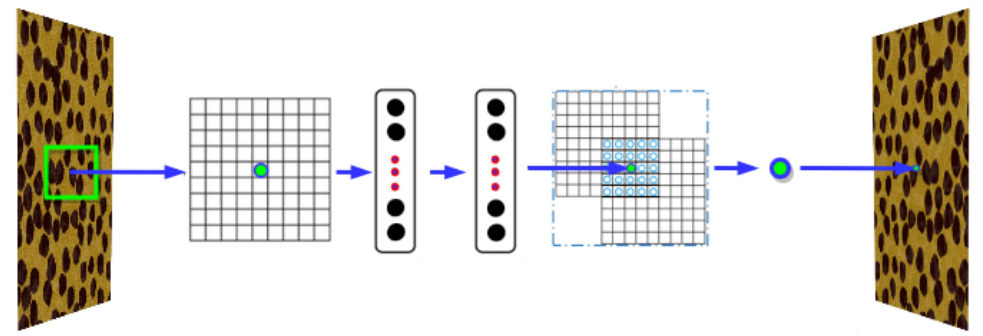
Figure 2. The original SRCNN developed by